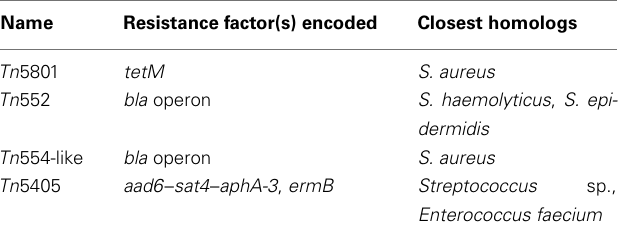
Table 4 | Mobile genetic elements associated with antibiotic resistance identified in S. pseudintermedius ED99.